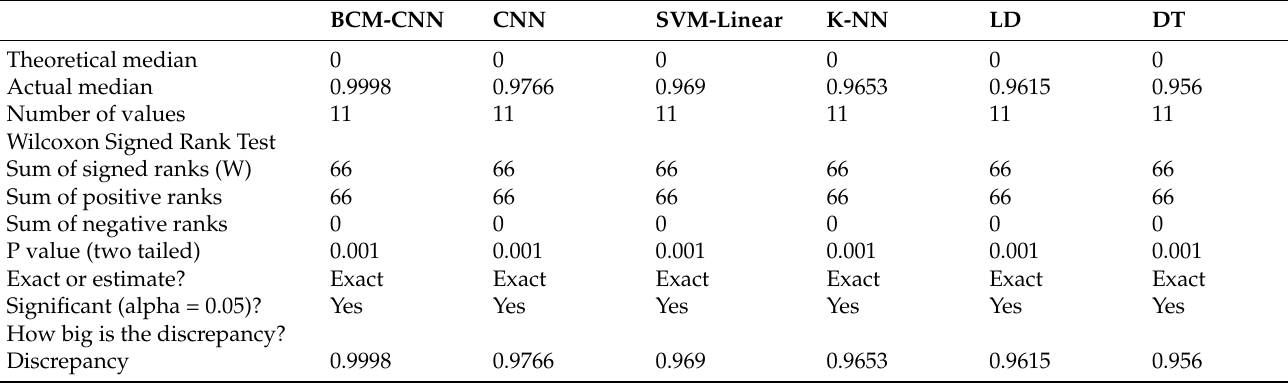
Table 9. Compared and proposed classifiers test results for Wilcoxon